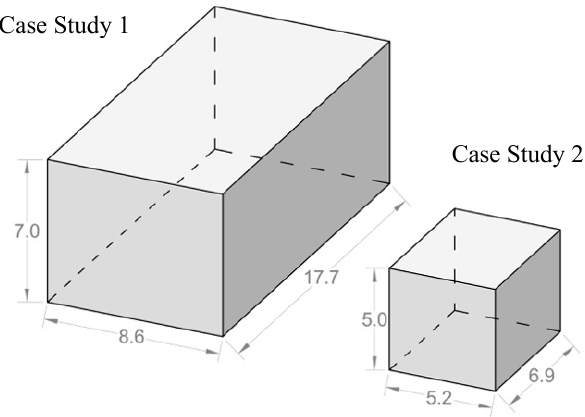
Figure 4. Geometrical proportions of the case studies analyzed (dimensions in meters).